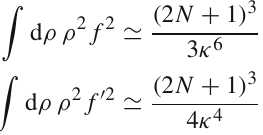
decreases because the Q-ball profile becomes increasingly dilute for κ → 1, suppressing the derivatives [18]. Using the numerical integrals as a function of κ or the small- κ approximations, we obtain the Q-ball charge and energy via Eq. (9). The numerical results are illustrated in Fig. 7 for some example parameters. For small κ and ω 0